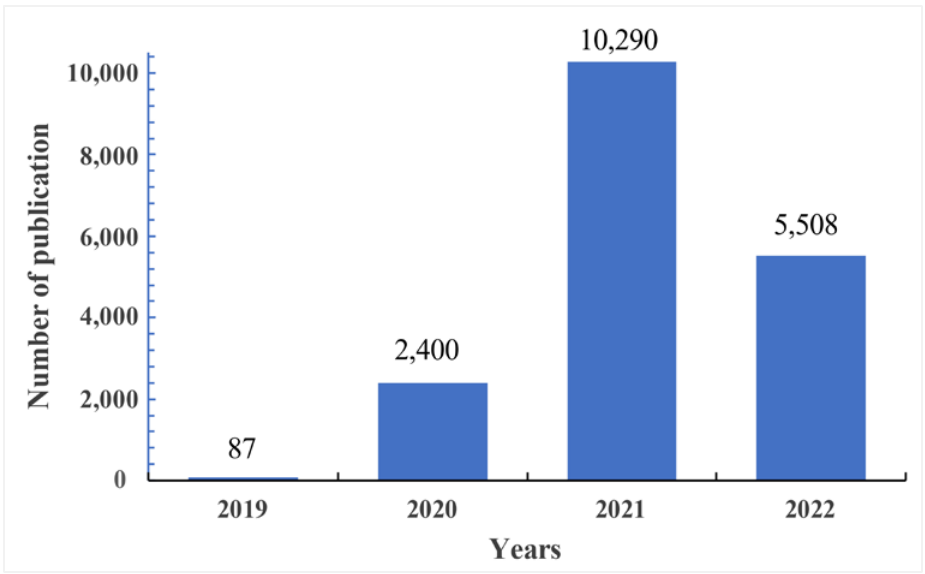
Figure 2. The annual distribution of in COVID-19 vaccine research.